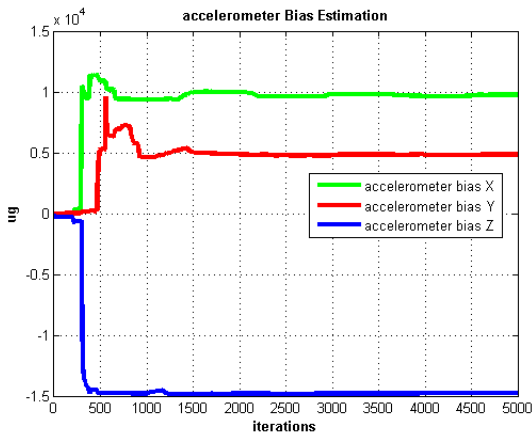
Figure 6. Accelerometer bias estimation.